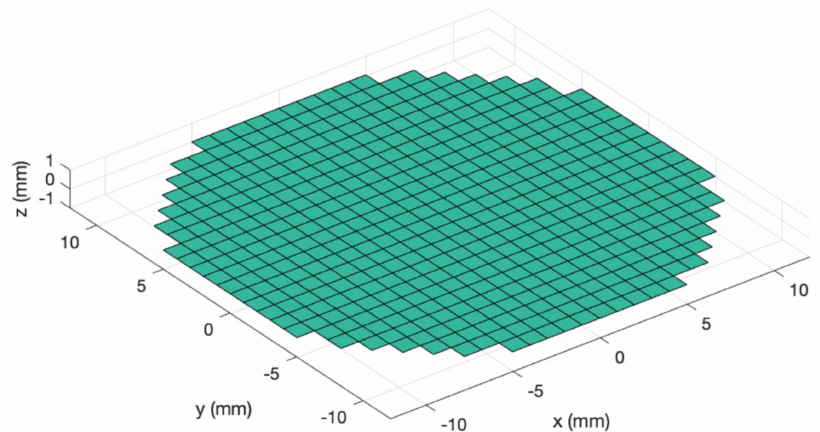
Figure 2. Example of a defined emitting transducer: circular and planar piston transducer with a diameter of D = 25 mm divided into square mathematical